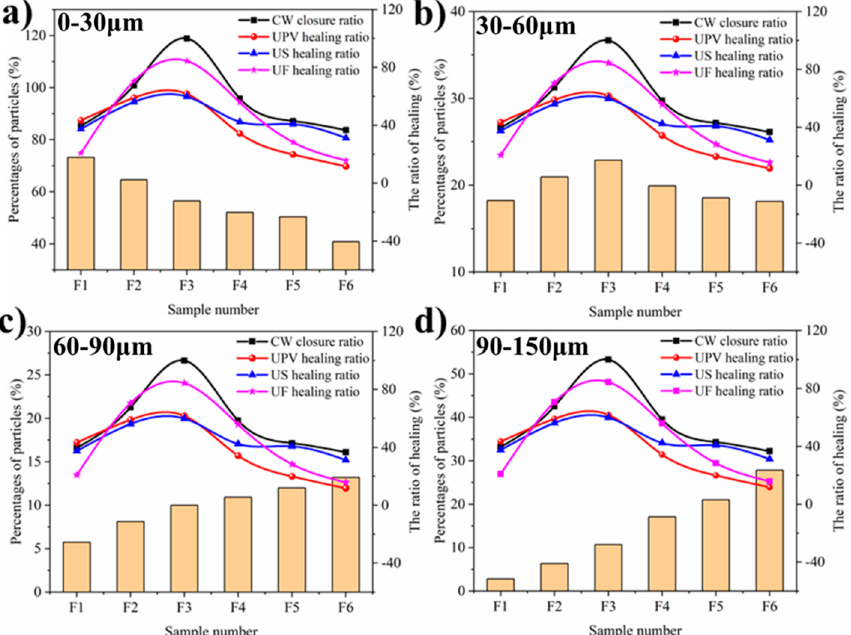
Figure 9. The relationship of self-healing rates with cement particles sizes (( a – d ) indicate the volume percentages of cement particles within a range of less than 30 µ m, 30~60 µ m, 60~90 µ m, and more than 90 µ m, respectively).